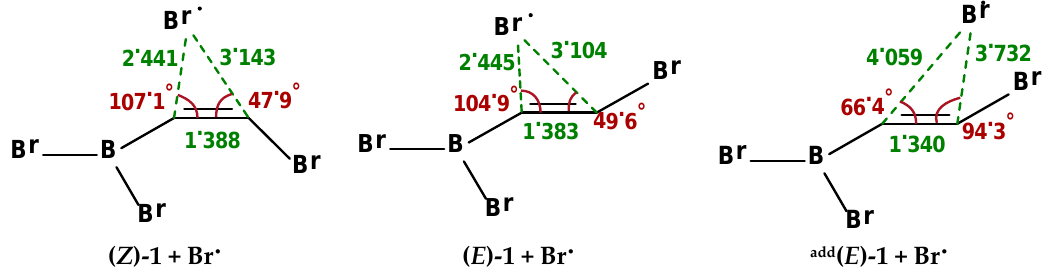
Figure 2. B3LYP-GD3BJ (ECP28MWB only for bromine atoms) total electronic energy profile for bromine radical addition to the “bromine end” of ( Z )-1 . For a key to atom color scheme, cf. caption of Figure 1.